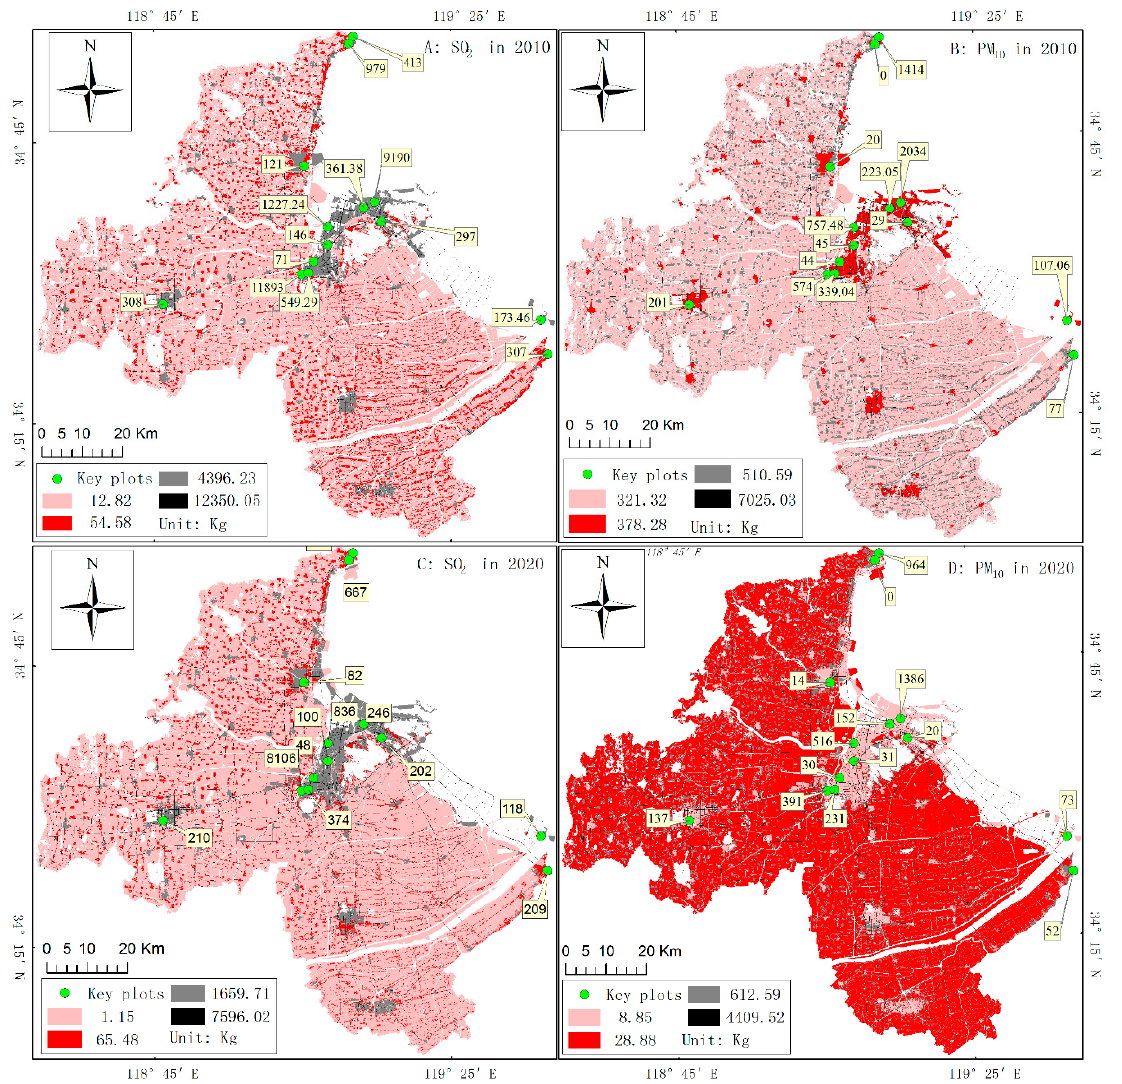
Figure 3. The source intensities of SO 2 and PM 10 in Lianyungang in 2010 and 2020: ( A ) and ( C ) are the concentrations of SO 2 in 2010 and 2020, respectively; and ( B ) and ( D ) are the concentrations of PM 10 in 2010 and 2020, respectively. The labels in the figures are the source intensity for key plots (unit: ton). The spatial concentrations of SO 2 and PM 10 were mapped for 2010 and 2020 and classified into